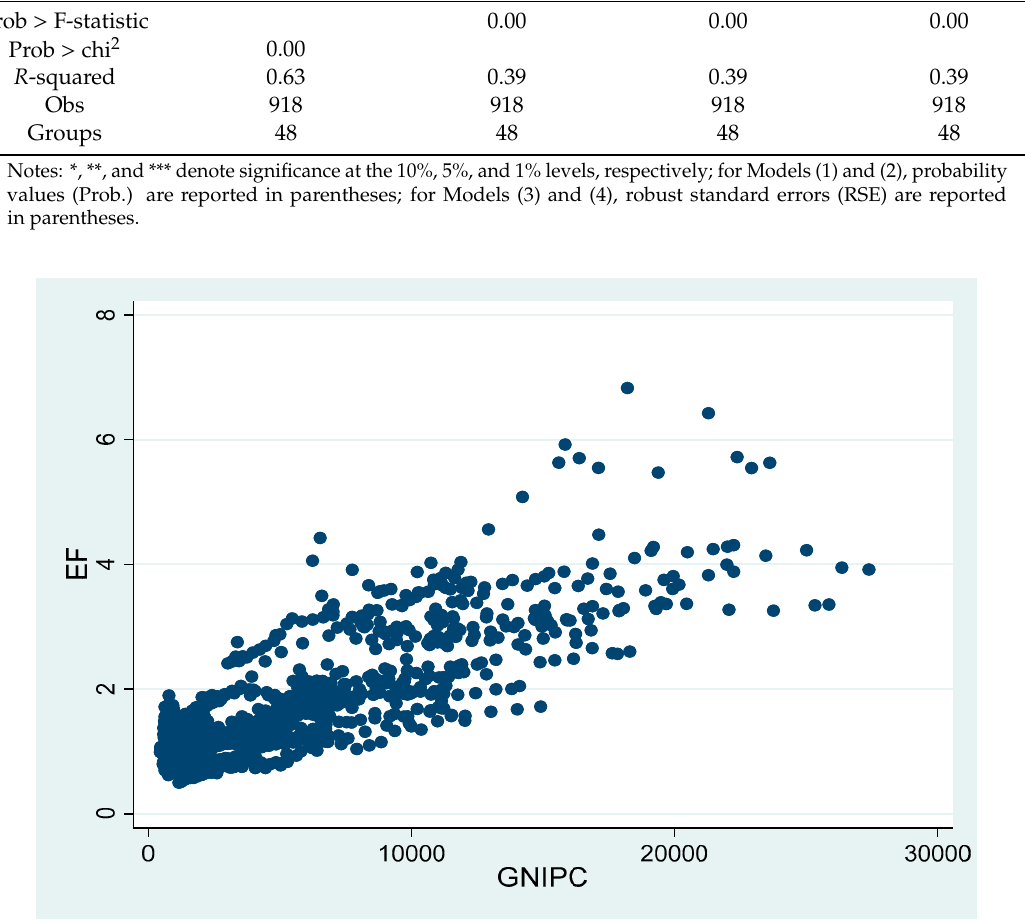
Figure 5. Scatter plot of EF and GNIPC of the developing countries.